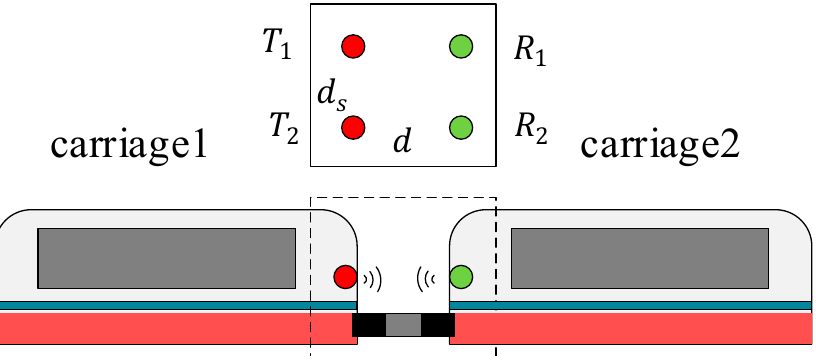
Figure 10. The coupling train of 2 × 2 MIMO system.